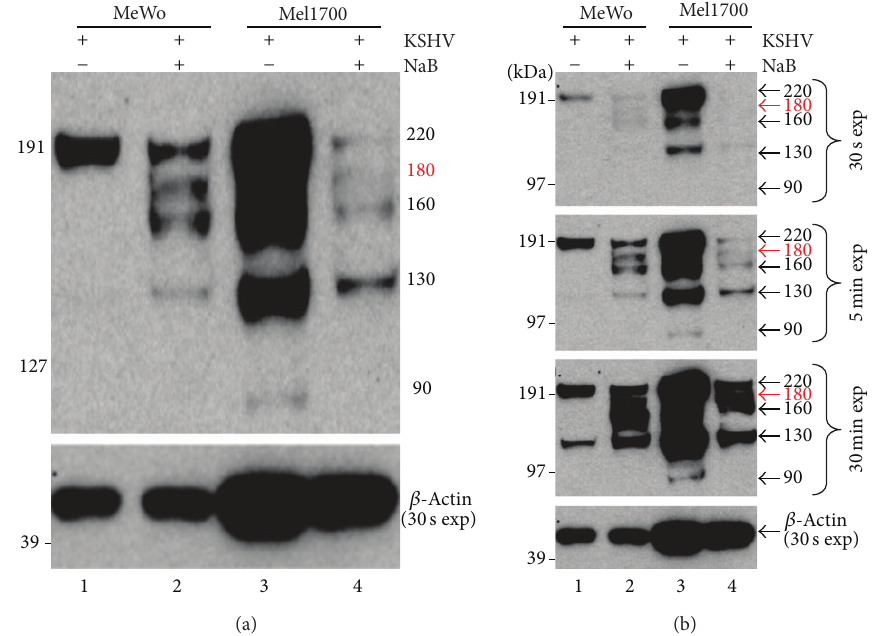
Figure 5: Differential expression of specific LANA isoforms in KSHV-infected MeWo and Mel1700 cells is associated with differences in viral lytic replication. (a) RIPA buffer lysates of rKSHV.219-infected MeWo and Mel1700 cells either untreated ( − ) or treated with NaB (+) for four days were resolved in SDS-PAGE and probed with anti-LANA antibody LN35. Blots were visualized with anti-rat-horse radish peroxidase (HRP)-conjugated secondary antibody. (b) 30 sec, 5 min., and 30 min. exposure times for the blot in (a), revealing “fine” differences between the samples with respect to expression of specific LANA bands. 𝛽 -Actin (30 sec. exposure) was used as loading control, and the estimated LANA band sizes are on the right side of the